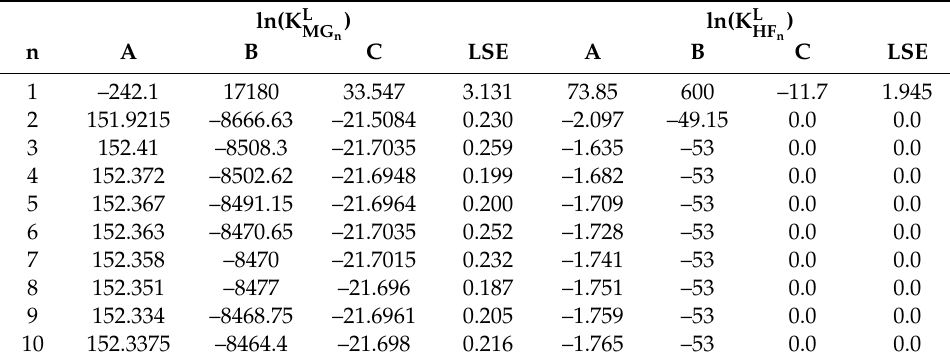
Table 2. In Aspen Plus ® , with the implemented correlation parameters of the equilibrium constants and least square errors